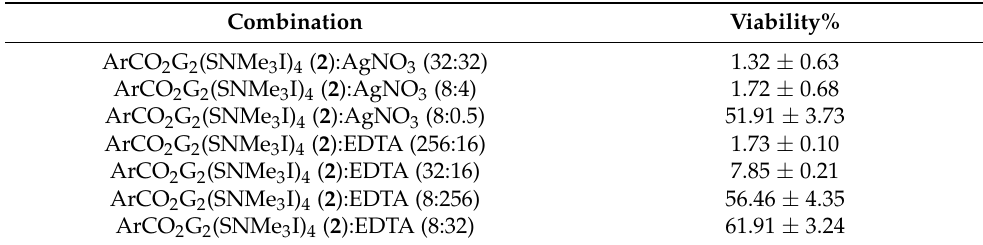
Table 3. Viability percentage of HeLa cells treated with combinations.